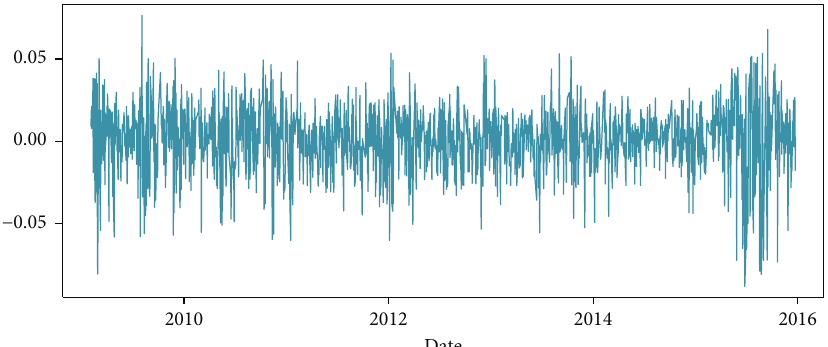
Figure 2: The Chinese daily agriculture index returns from February 2, 2009 to December 24, 2015.